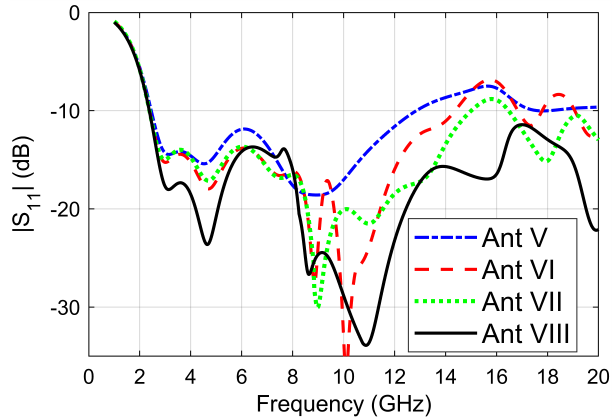
FIGURE 7. Simulated |S 11 | of parasitic elements design steps for antennas shown in Fig. 6.